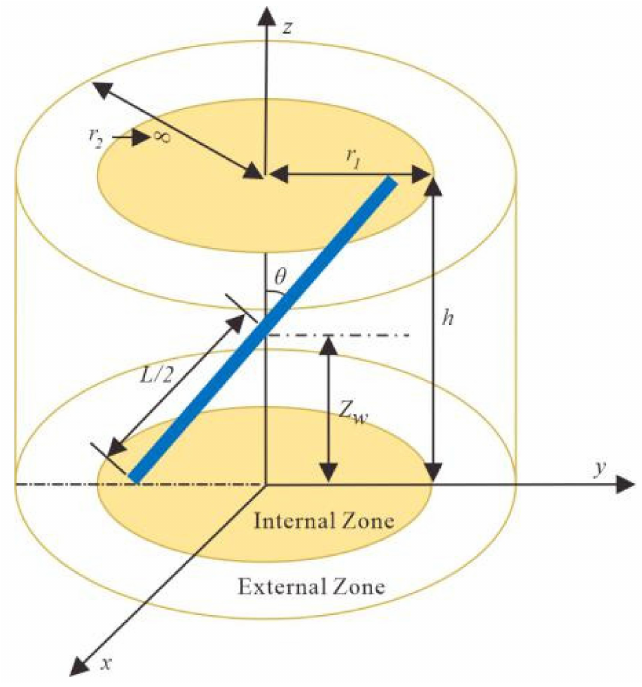
Figure 1. Schematic diagram of the physical model.